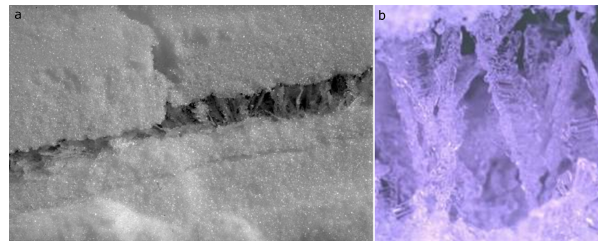
Figure 1. (a) Typical slab – weak layer configuration suitable for avalanche release. The weak layer is composed of surface hoar which is intact on the right and partially ruptured on the left. © ASARC from Jamieson and Schweizer (2000). (b) Zoom on a surface hoar crystal © ASARC.